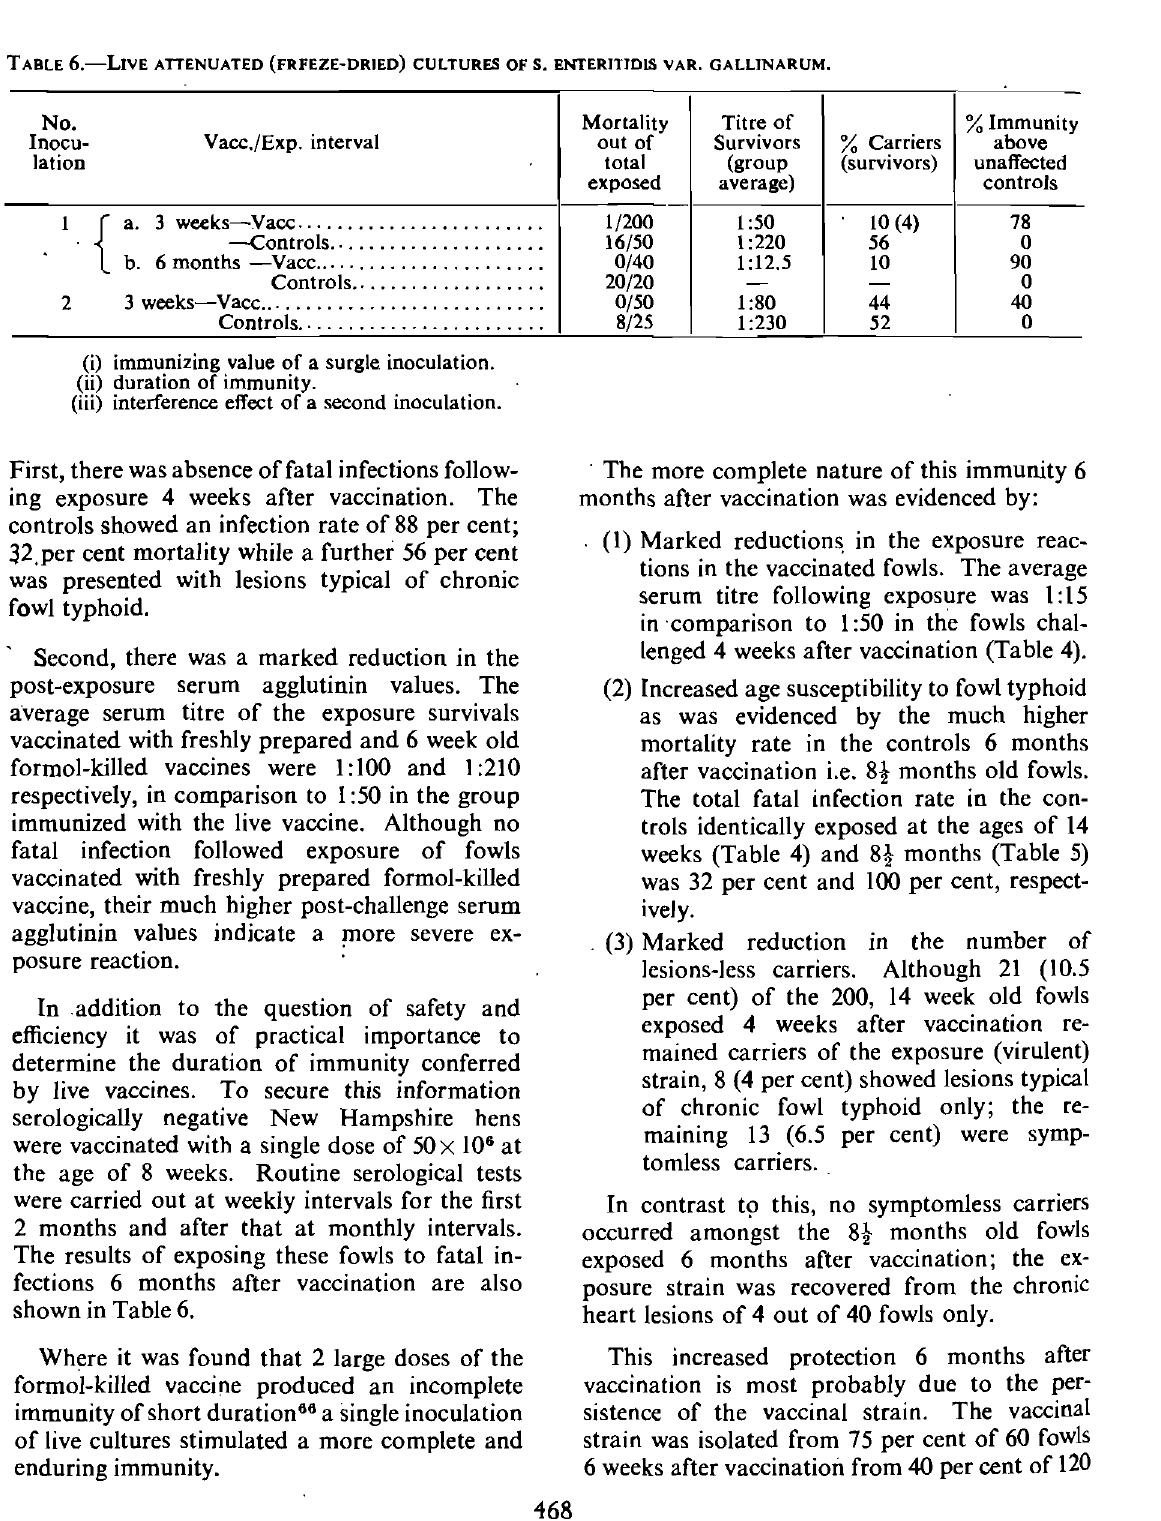
TABLE 6.-LIVE ATTENUATED (FRFEZE-DRJED) CULTURES OF S. ENTERITIDIS VAR. GALllNARUM. No.